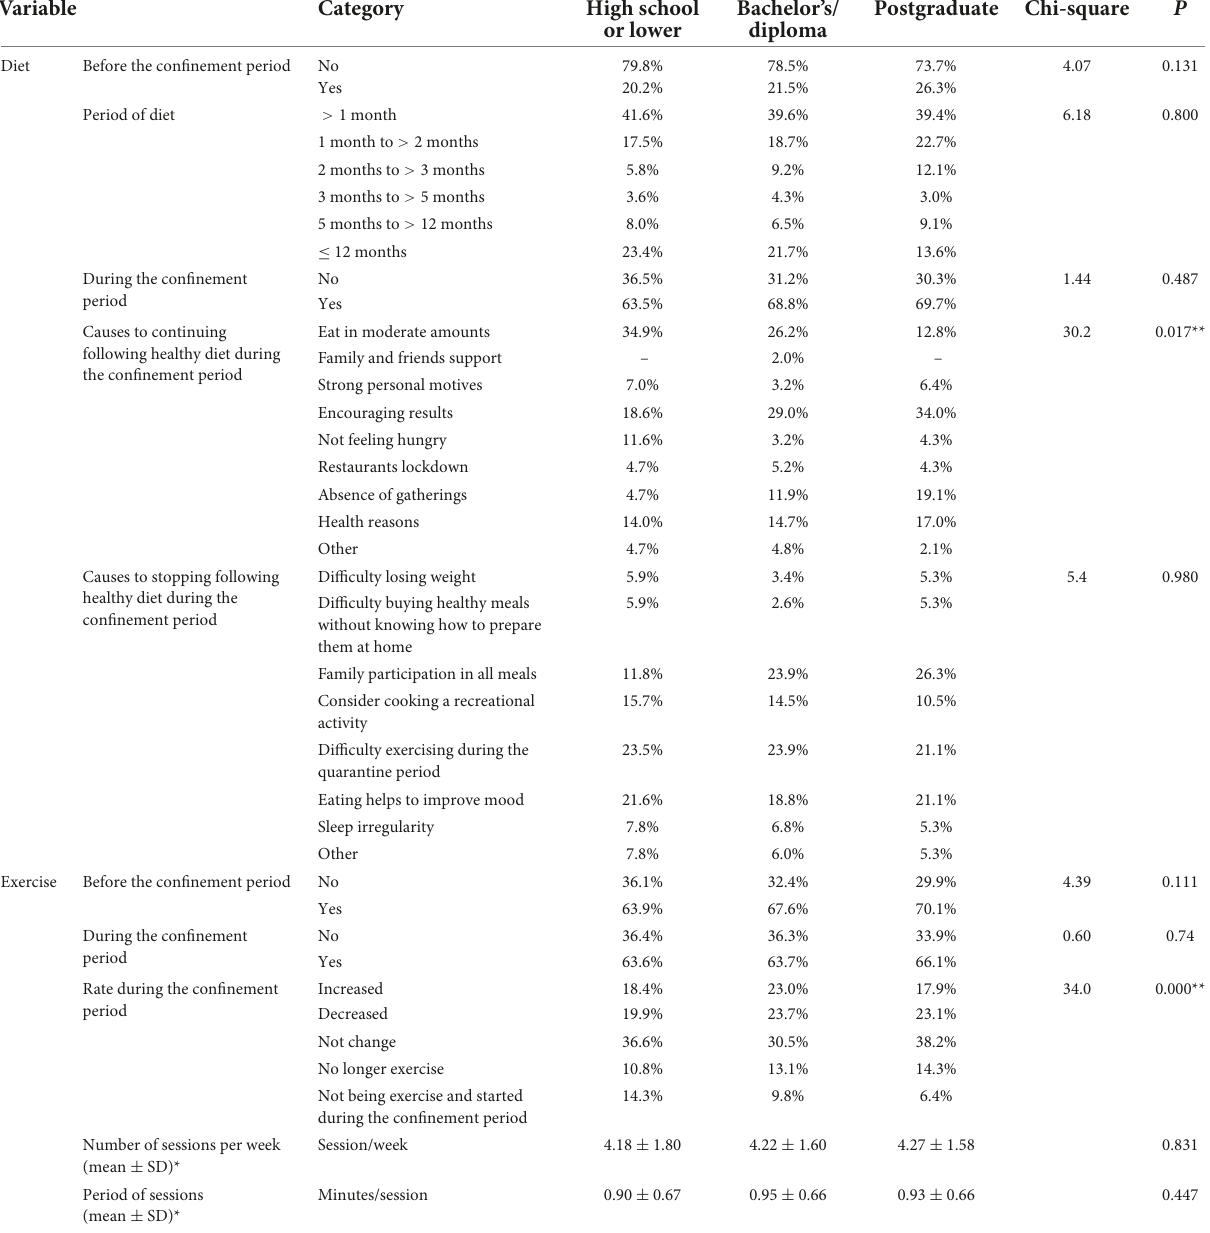
TABLE 4 Education, diet, and exercise before and during the confinement period.